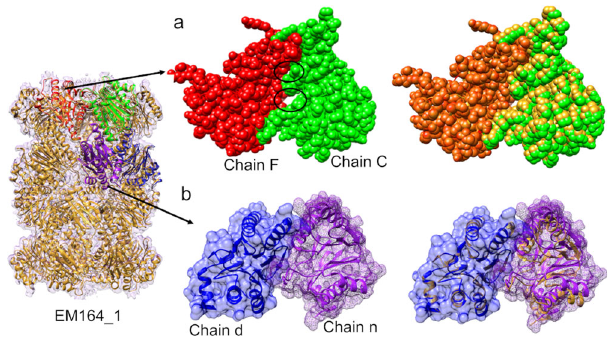
Fig. 4 Scoring the interfaces in the target T0002 from 2016 EM model challenge. a Scoring the interfaces between the alpha subunits ’ ring in the model structure EM164_1, the chains (F and C), which form a negatively- scoring interface is shown in red and green and the target structure is shown in golden. The surface for the interface forming chains (F and C) are shown as spheres and the loose packing at the interface is marked with black ovals. b Scoring the interfaces in the beta subunits ’ ring of the 20S proteasome, one of the targets in EM model challenge (T0002). The target structure is shown in golden and the chains forming the interface (n and d) in the model structure (EM164_1) being assessed are shown in blue and purple. The surface (mesh) of the chains forming interface are shown to highlight the clashes at the interface formed by chains n and d in the